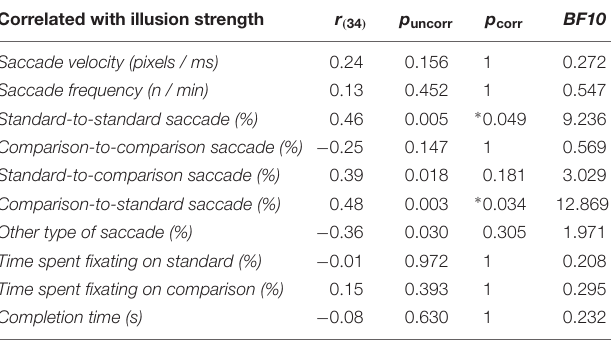
TABLE 4 | Correlations between illusion strength and different eye-tracking